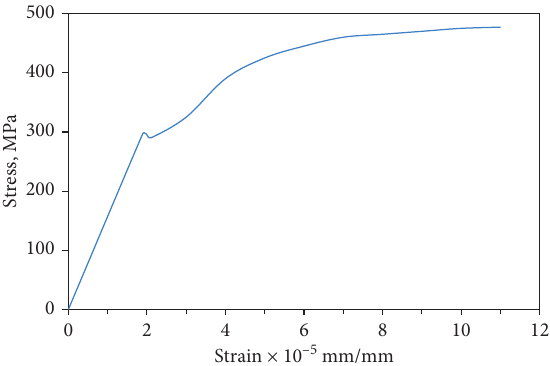
Figure 4: Stress-strain relationship of NSM steel bar (Ø10mm).